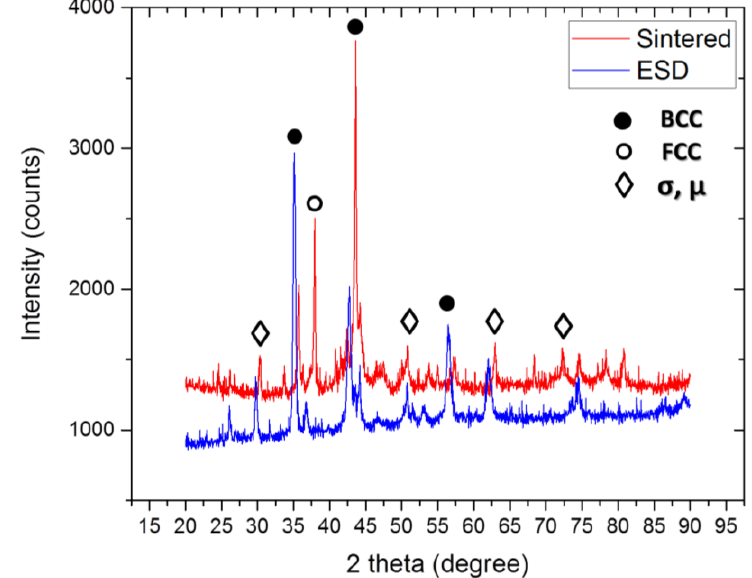
Figure 5. XRD pattern for the bulk and coated sample of CoCrFeNiMo0.85.